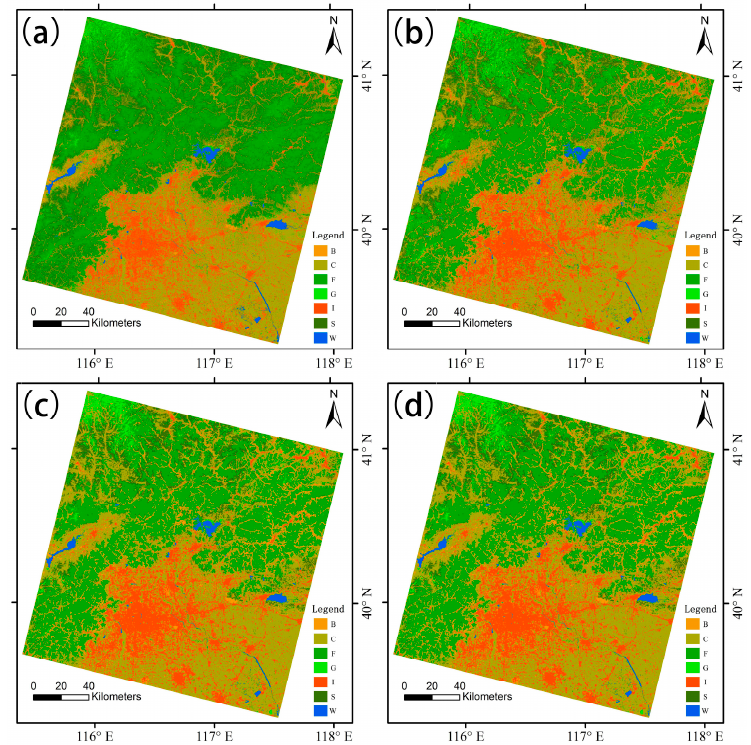
Figure 6. LULC classification maps. (Note: B: bare land, C: cropland, F: forest, G: grass, I: impervious, S: shrub, W: water; ( a ) KNN + spectral features only; ( b ) KNN + spectral features +all adjacent region features (S ≤ 19); ( c ) SVM + spectral features only; and, ( d ) SVM+ spectral features +all adjacent region features (S = 17)).